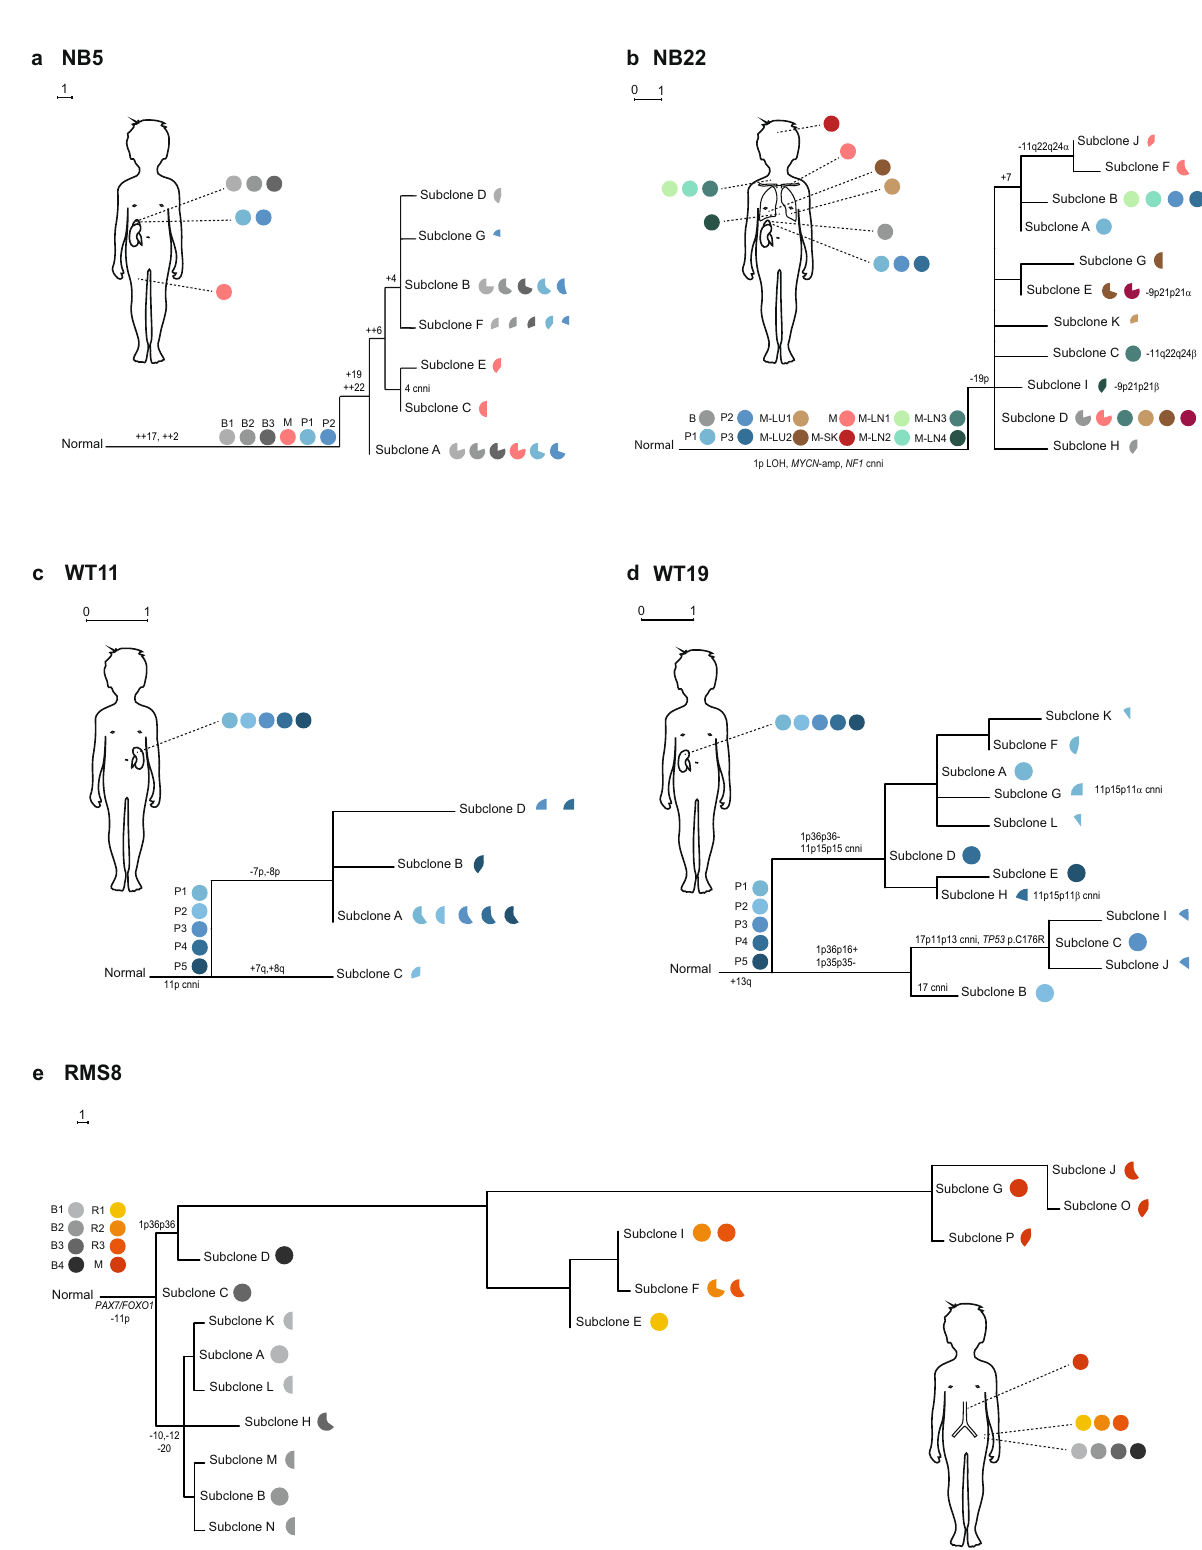
polyclonal seeding was observed in NB22 (Fig. 2b), a patient with progressive tumor growth across multiple metastatic locations. Here there was more subclonal variation among the lymph node metastases than among metastases to distant organs. The metastases to distant organs often presented as solitary branches, exempli fi ed by the same subclone colonizing both the lung and skull. This might indicate that the threshold for tumor cells to